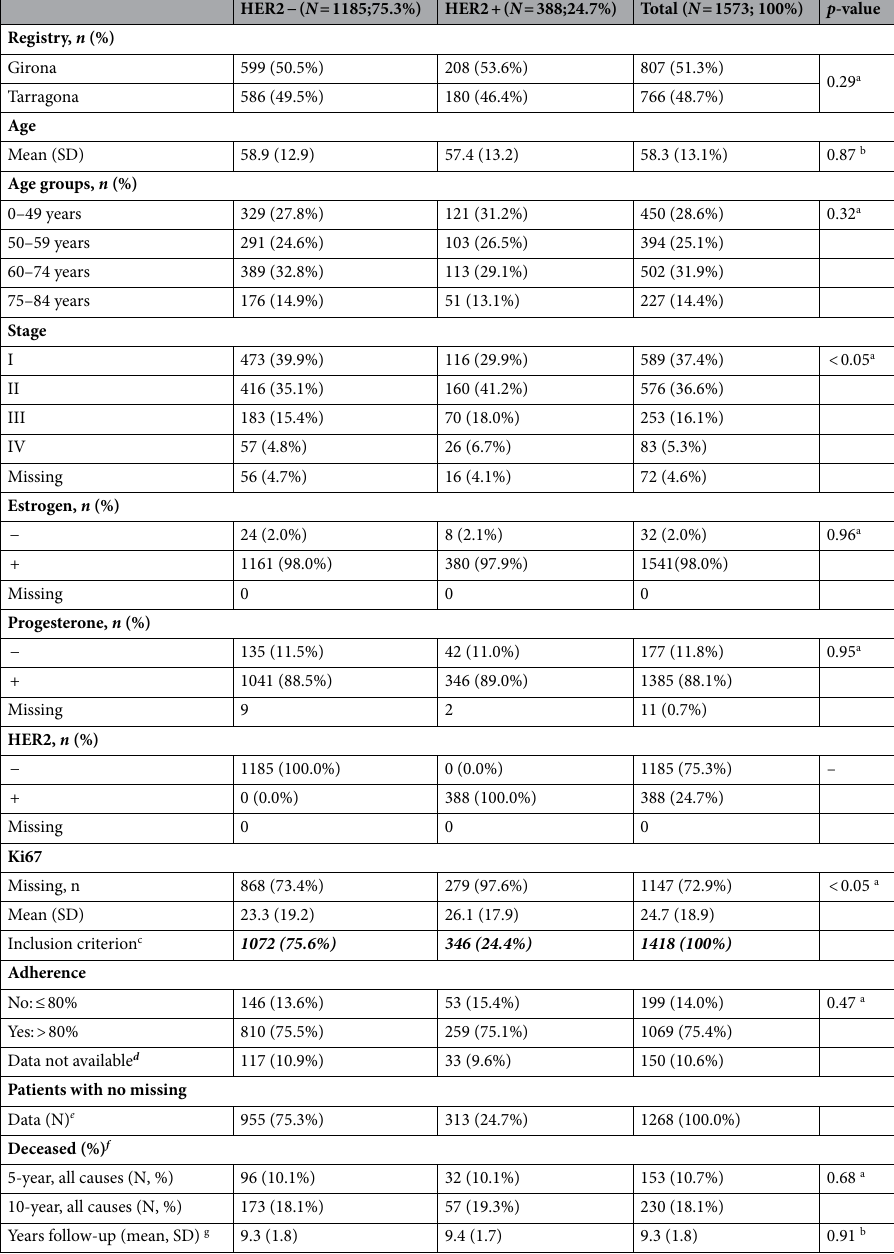
Table 1. Characteristics of patients diagnosed with hormone receptor-positive breast cancer before the age of 85 years in Girona and Tarragona, 2007 to 2009. a chi-square test, b t-test, c Inclusion criterion: patients diagnosed in stages I, II or III, d Patients with no data available on adherence to endocrine treatment among patients who met the inclusion criterion n = 1418, e Patients with no missing data among those who met the inclusion criterion who were included in the statistical modeling, f number of deaths at 5 and 10 years of follow-up among the N = 1268 patients included in the modeling, g follow-up of the N = 1268 patients included in the modeling. Significant values are in